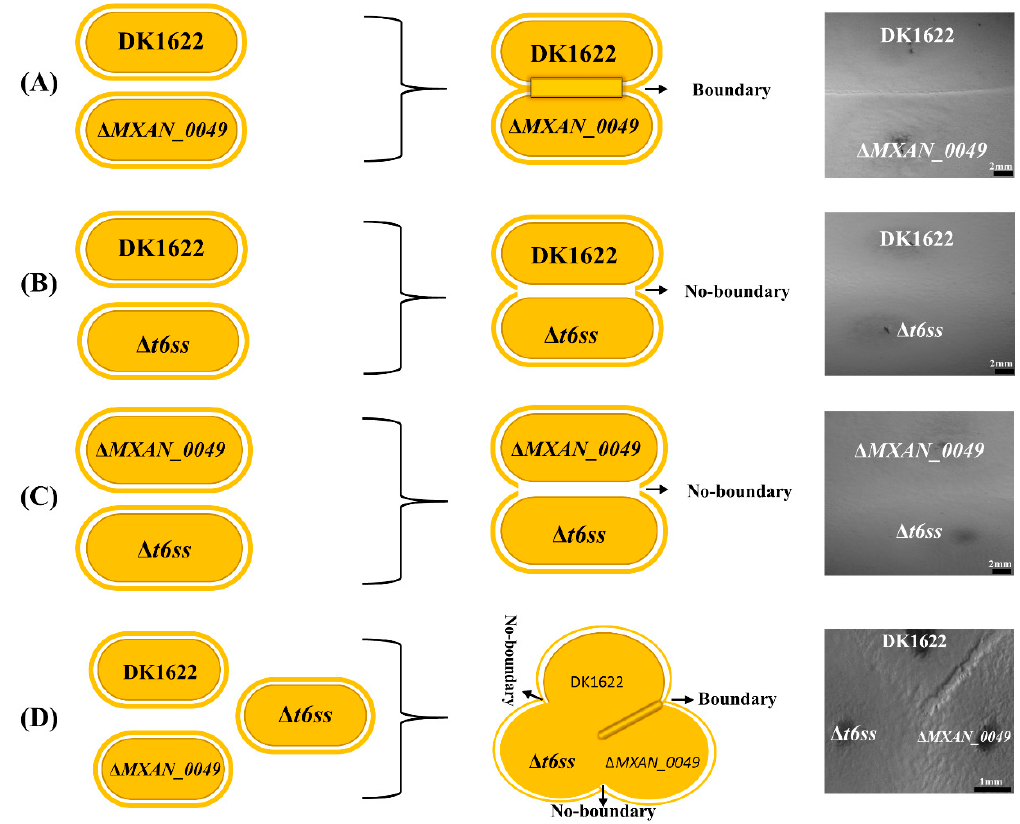
Figure 5. Knockout of T6SS gene cluster MXAN_4800-4813( ∆ t6ss ) for assessment of its role in the boundary formation. A visible boundary appeared at the point of interaction between DK1622 and ∆ MXAN_0049 ( A ). When DK1622 interacted with ∆ t6ss , no boundary formed ( B ). Similarly, in the case of ∆ MXAN_0049 and ∆ t6ss interaction, no boundary appeared ( C ). When all three strains, ∆ MXAN_0049 , ∆ t6ss , and DK1622, interacted with each other on the same plate, only a visible boundary appeared in the case of DK1622 and ∆ MXAN_0049 at the point of interaction ( D ).